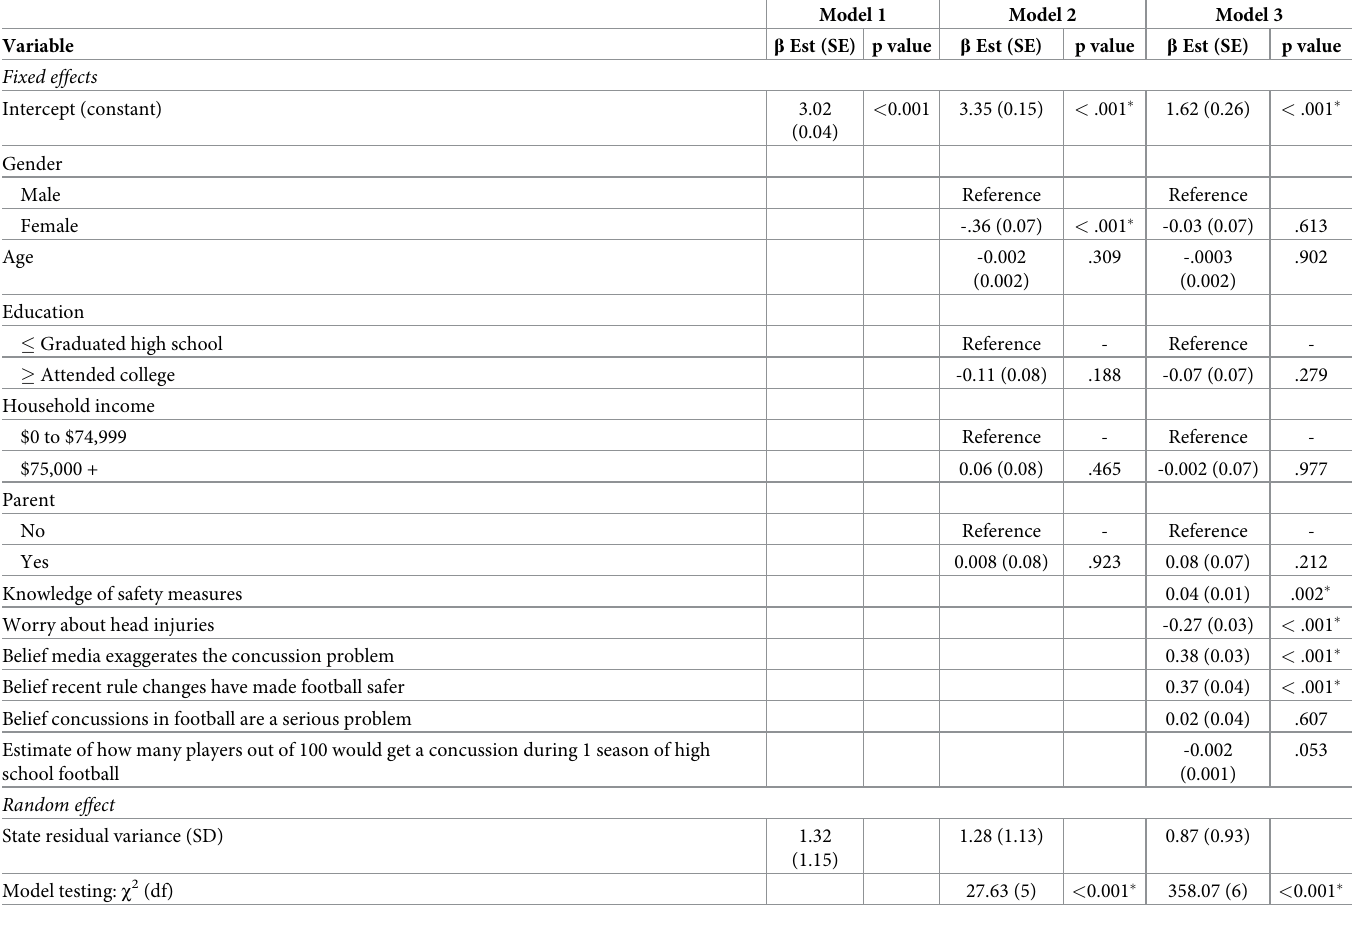
Table 2. Willingness to allow high school tackle football participation regression